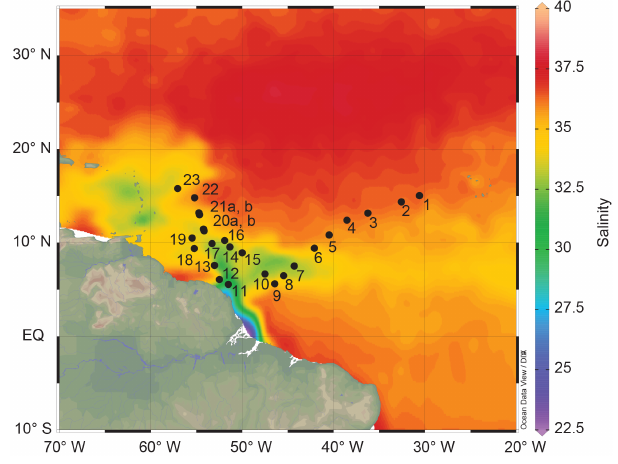
Figure 2. Map of tropical North Atlantic showing the study site. Location of the stations indicated. Aquarius sea-surface salinity (SSS) satellite data from ERDAPP (30-day composite, centered on 1 September 2014, https://coastwatch.pfeg.noaa.gov/erddap/index.